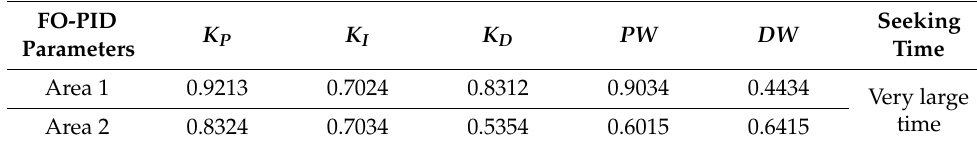
Figure 5. Complete SIMULINK model for the two-area power system. Table 4. Efforts implementing conventional-FOPID controller.